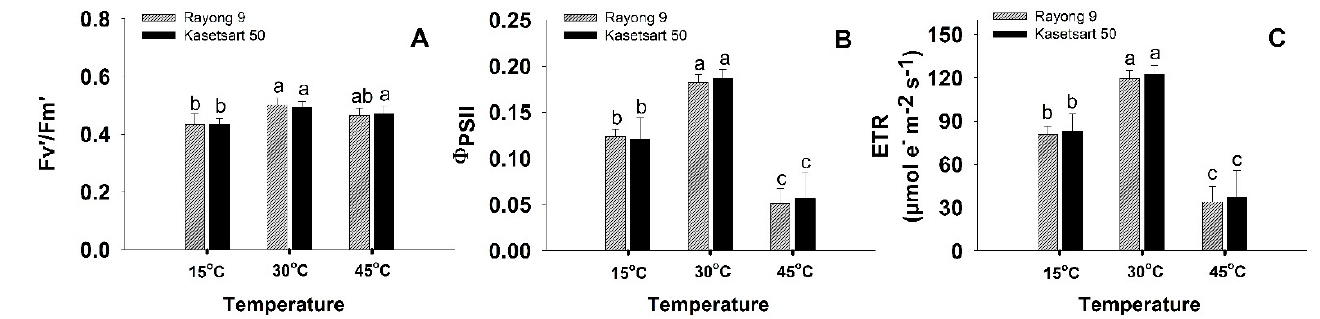
Figure 2. The effects of short-term exposure to different temperatures (15, 30, and 45 °C) on chloro- phyll fluorescence parameters including maximum quantum yield efficiency of photosystem II (Fv’/Fm’) ( A ), effective quantum yield of PSII photochemistry ( Ф PSII) ( B ), and electron transport rate (ETR) ( C ) of cassava cvs. Rayong 9 and Kasetsart 50. Means (±SD) which are significantly dif- ferent ( p < 0.05) among treatments for each cultivar are denoted by different lower-case letters. The significant differences between cassava genotypes are denoted with *.